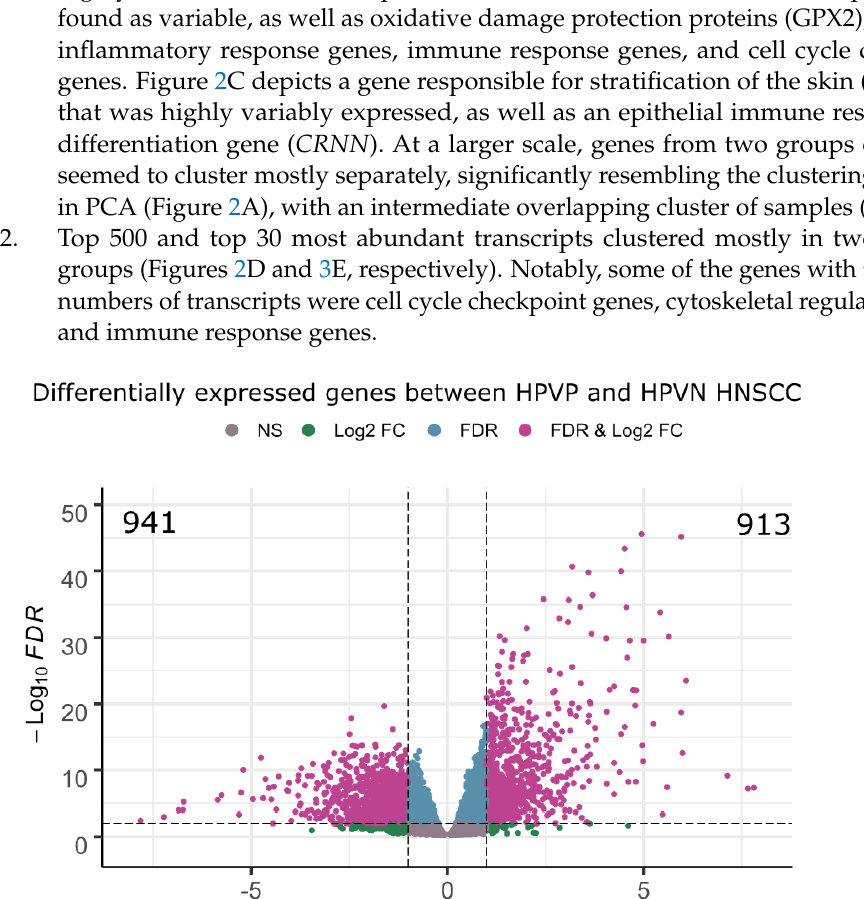
Figure 2 . Clustering of the TCGA HNSCC HPVP and HPVN samples and genes. PCA and heatmap clustering shows distinct patient groups as we classify them. ( A ) PCA shows that patients classify in two separate groups for the most part, confirming that separation in HPVP and HPVN groups by p16 expression and in situ hybridization was a valid parameter; ( B – E ) are heatmaps of the most variable genes ( B , C ) and most abundant transcripts ( D , E ) among n = 114 HNSCC samples; ( B ) shows the top 500 most variable genes, while a closer look at the top 30 most variable genes is shown in ( C ); top 500 transcripts with the highest mean values are depicted in ( D ) with a zoomed-in perspective to the top 30 in ( E ) HPVN samples (labeled in black) and HPVP (in red colored numbers).